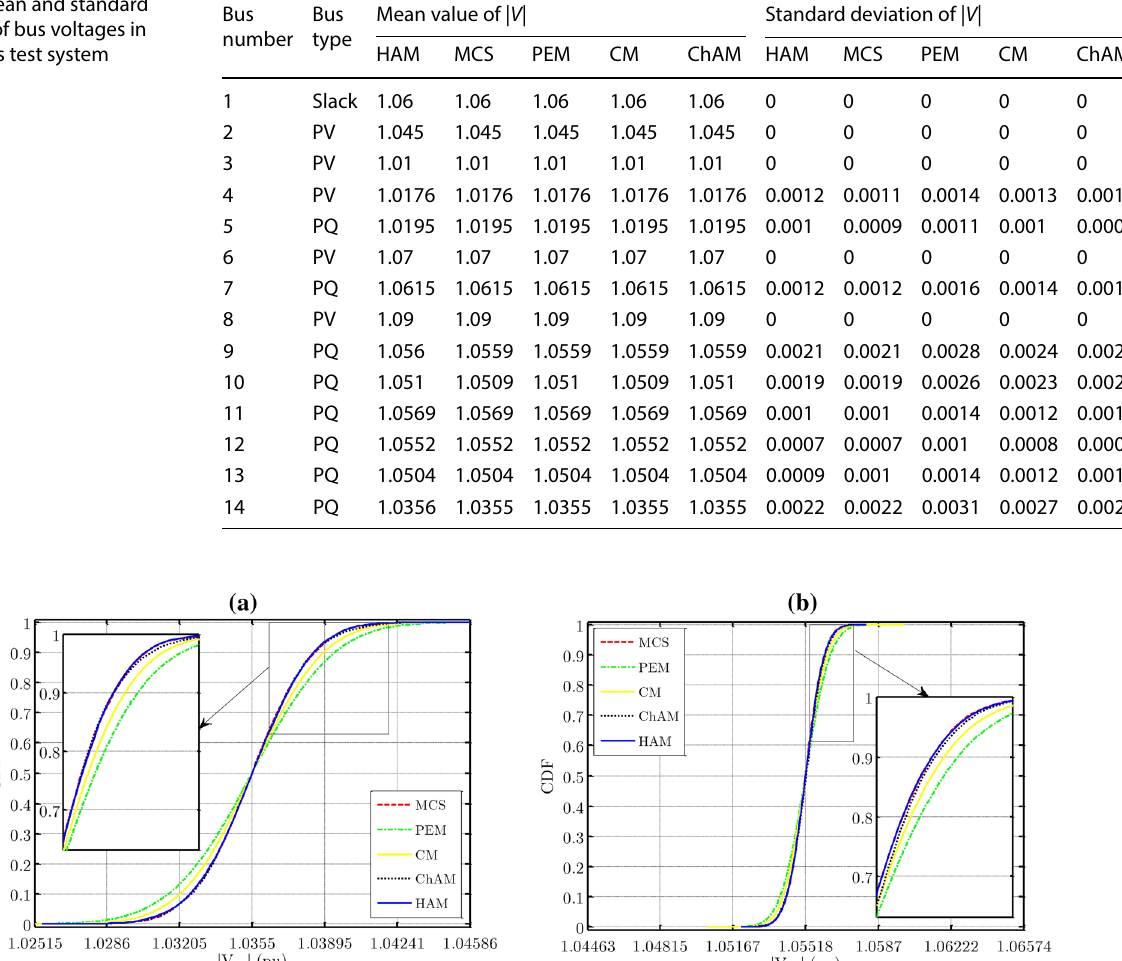
Bus Bus Mean value of | V | number type